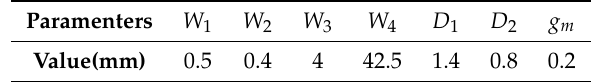
Table 4. The parameters of the magnetic metamaterial unit